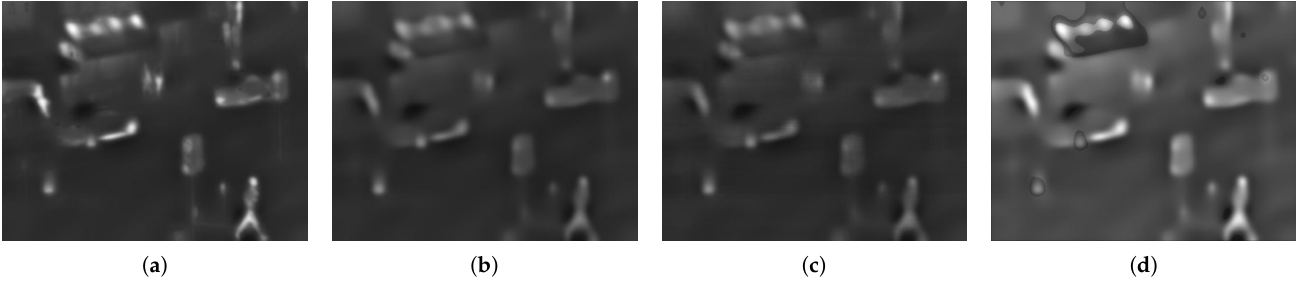
Figure 5. Comparison map of base layer fusion: ( a ) Proposed; ( b ) Weighted Average; ( c ) Based on Information Entropy; ( d ) Based on Average